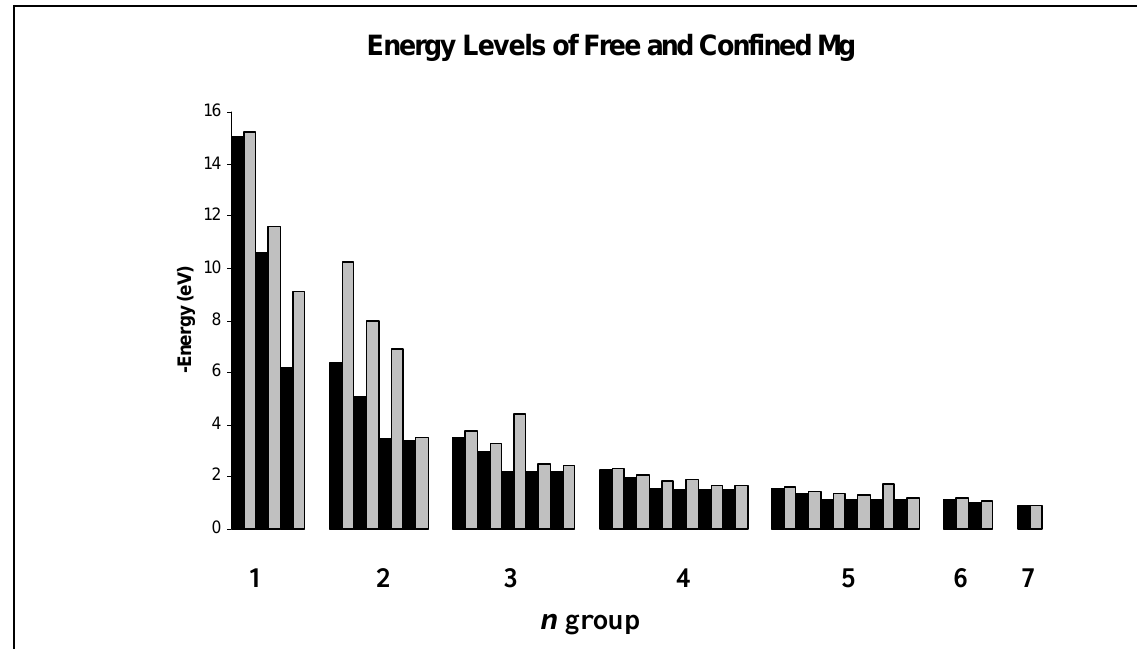
Figure 2. Comparison of energy levels in eV for free and encapsulated magnesium as calculated in our work. Format is the same as in Figure